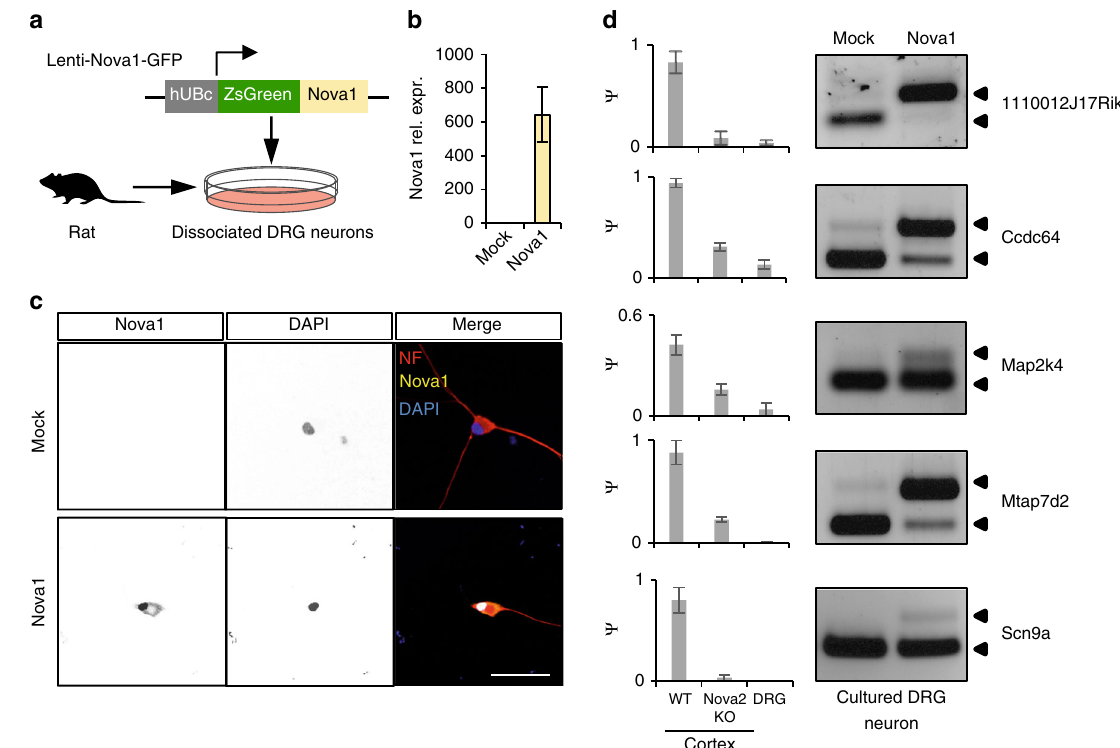
Fig. 7 Overexpression of Nova in DRG neurons promotes the “ mature ” splicing pattern observed in CNS neurons. a Schematic illustrating overexpression of Nova1 in rat primary DRG neuronal culture using a Nova1-GFP-expressing lentivirus. A GFP-expressing lentivirus is used as a Mock control. b qRT-PCR of Nova1 mRNA expression level in DRG neurons transduced with Nova1-GFP-expressing or GFP-expressing lentiviruses. The average relative expression level normalized to Mock-transduced cells is shown. Error bars represent standard deviation ( n = 3). c Immunostaining of primary rat DRG neurons transduced with Nova1-GFP-expressing or GFP-expressing lentiviruses. Nova1 protein has predominant nuclear localization. Scale bar, 50 µ m. The insert shows the zoom-in view of the cell. d Changes in the alternative splicing of Nova target exons upon Nova1 overexpression in rat primary DRG neurons. For each exon, the exon inclusion level in WT and Nova2 KO cortex, and DRG sensory neurons, as quanti fi ed by RNA-seq, is shown in the barplot on the left. Error bars represent the standard deviation ( n ≥ 3). A representative gel image on the right shows inclusion of the alternative exon in Mock-transduced and Nova1-transduced cells detected using RT-PCR analysis ( n = 3). The bands corresponding to the inclusion (top) and skipping of the exon (bottom) are